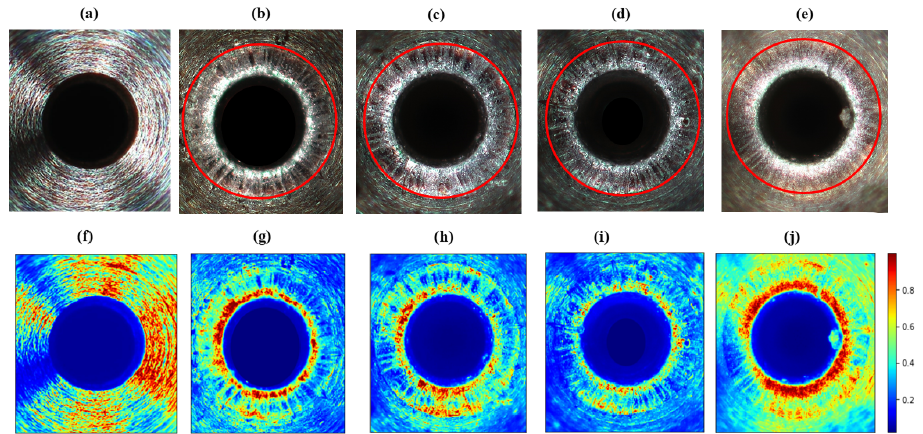
Figure A3. Comparison of injector valve ball seats between ( a ) normal injector, ( b – e ) the worn injectors after the experiment, and ( f – j ) the surface profiles for the respective injector valve